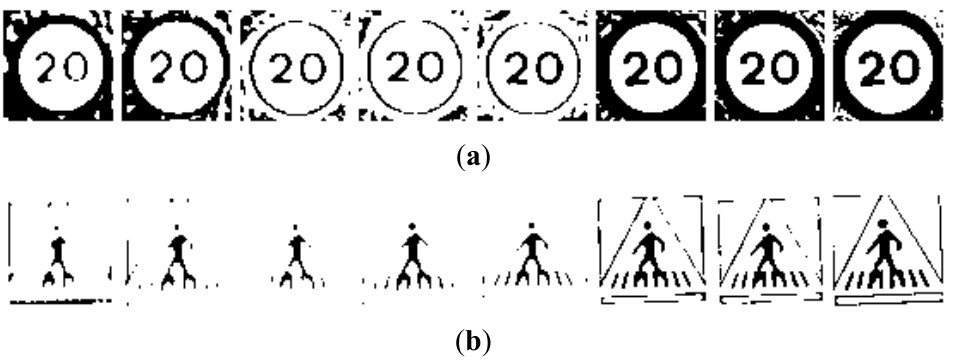
Figure 10. Examples of candidates in Figure 5 processed using bimodal thresholding for ( a ) Red road signs. ( b ) Blue road